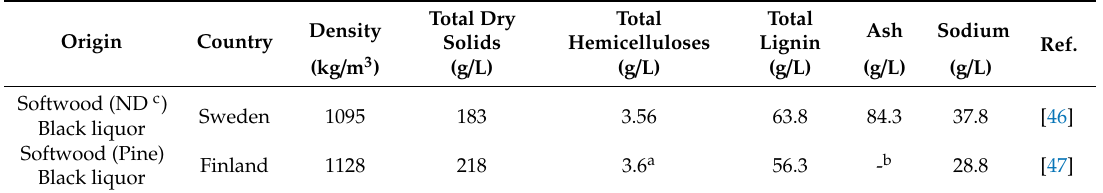
Table 1. Compositions of softwood weak black liquor achieved from two Kraft pulp mills. Data retrieved from Arkell et al. [46] and Alekhina et al. [47].